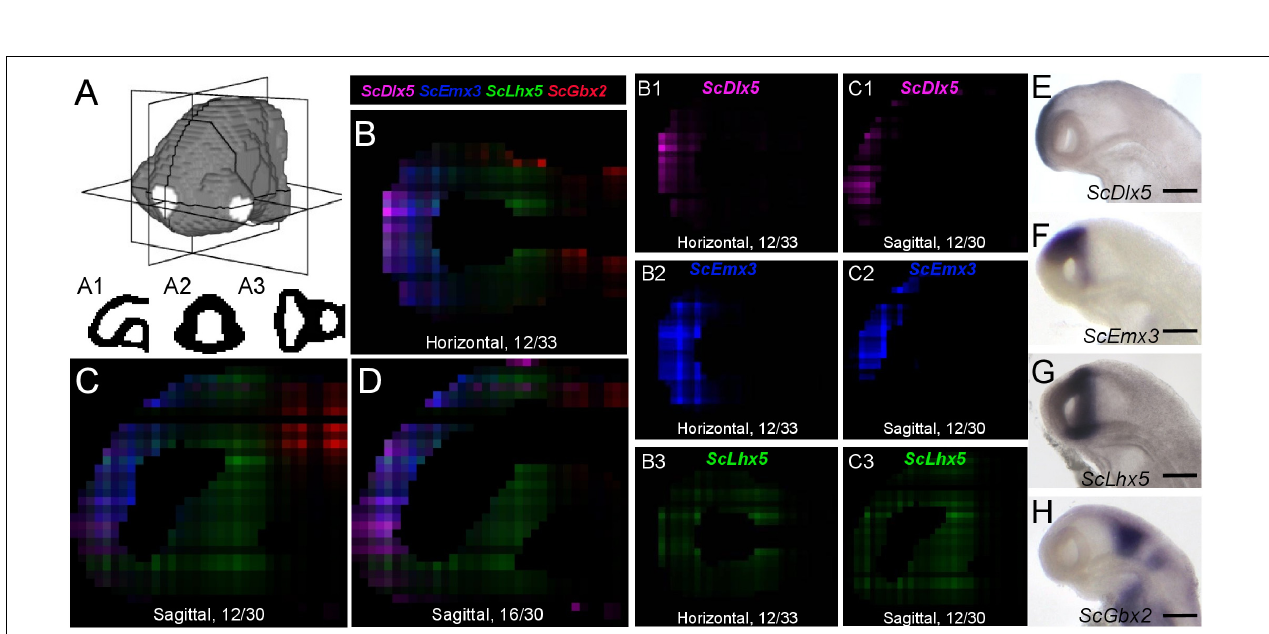
FIGURE 3 | Digital profiles reproduce regional patterns along AP axis. (A) Scheme representing the digitized model of stage 17 catshark head with sagittal, transverse and horizontal digital section planes shown as white rectangles. (A1 , A2 , A3) show examples of digitized sections along these planes. (B–D) Digital horizontal (B) and sagittal (C,D) sections showing merged profiles of ScDlx5 (magenta), ScEmx3 (blue), ScLhx5 (green), and ScGbx2 (red). Sections are numbered from dorsal to ventral in panel (B) and from left to right in panels (C,D) . (B1–3 , C1–3) Digital sections showing the individual profiles, respectively, merged in panels (B , C) for ScDlx5 (B1,C1) , ScEmx3 (B2,C2) , and ScLhx5 (B3,C3) . (E–H) Left lateral views of stage 17 catshark embryonic heads after ISH with probes for ScDlx5 (E) , ScEmx3 (F) , ScLhx5 (G) , and ScGbx2 (H) . Scale bars = 200 µ m.